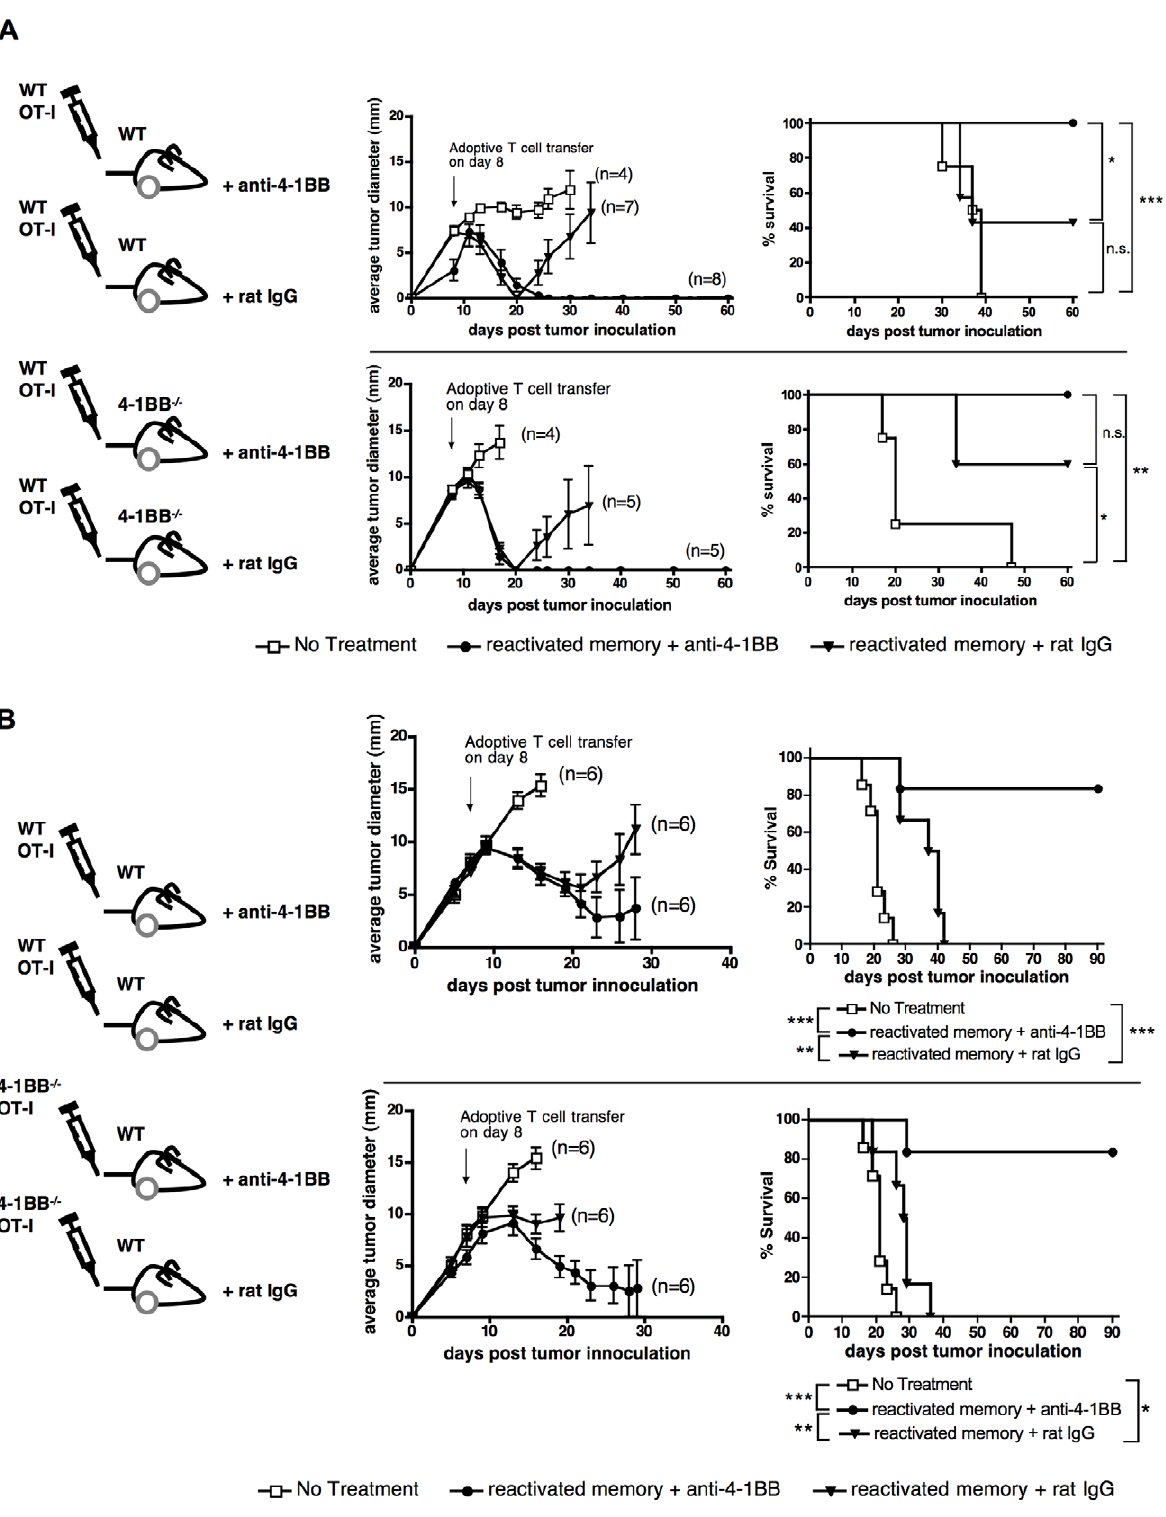
Figure 6. 4-1BB on either transferred T cells or host cells is sufficient for the therapeutic effect of anti-4-1BB. (A) E.G7 tumors were allowed to grow for 8 days in WT mice or 4-1BB-deficient mice and then inoculated with 3 6 10 6 WT reactivated memory cells followed by two doses of anti-4-1BB or rat IgG treatment. Average tumor growth and survival of tumor bearing mice is shown, where n indicates the number of mice per group. Results obtained with another set of 4-1BB 2 / 2 mice showed a similar trend (data not shown). (B) WT mice bearing 8 day-tumors were treated with WT or 4-1BB 2 / 2 reactivated OT-I memory cells followed by two doses of anti-4-1BB or rat IgG. Average tumor growth and survival curves of the tumor bearing mice are shown. Survival curves were analyzed by the LogRank test, with *P , 0.05, **P , 0.01 and ***P , 0.001 .